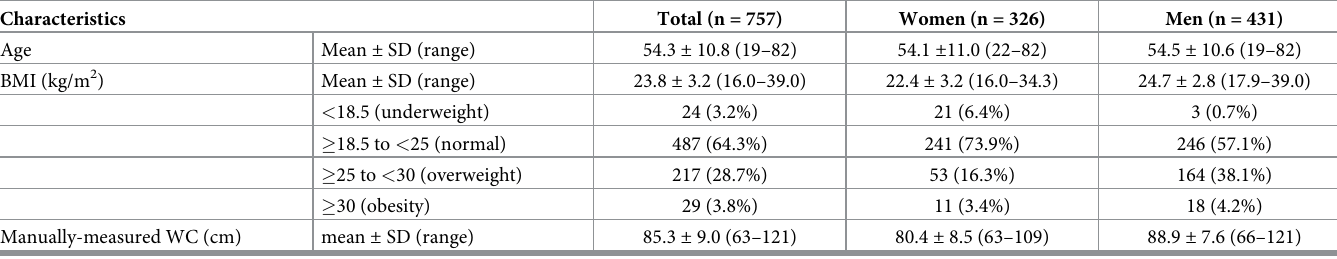
Table 1. Characteristics of the final study sample.